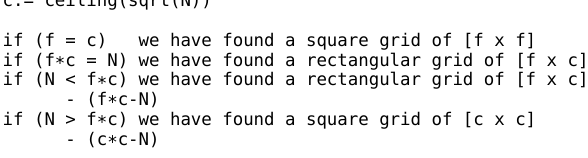
Fig. 3. Example subdivisions of a square into 4 , 6 , 8 , and 10 rectangular sections.